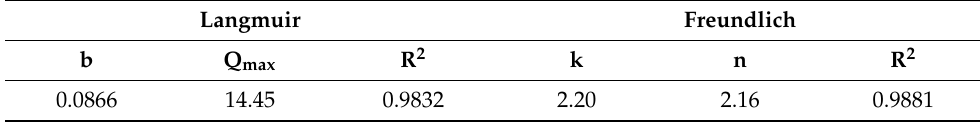
Table 5. Adsorption parameters of Langmuir and Freundlich adsorption isotherms.